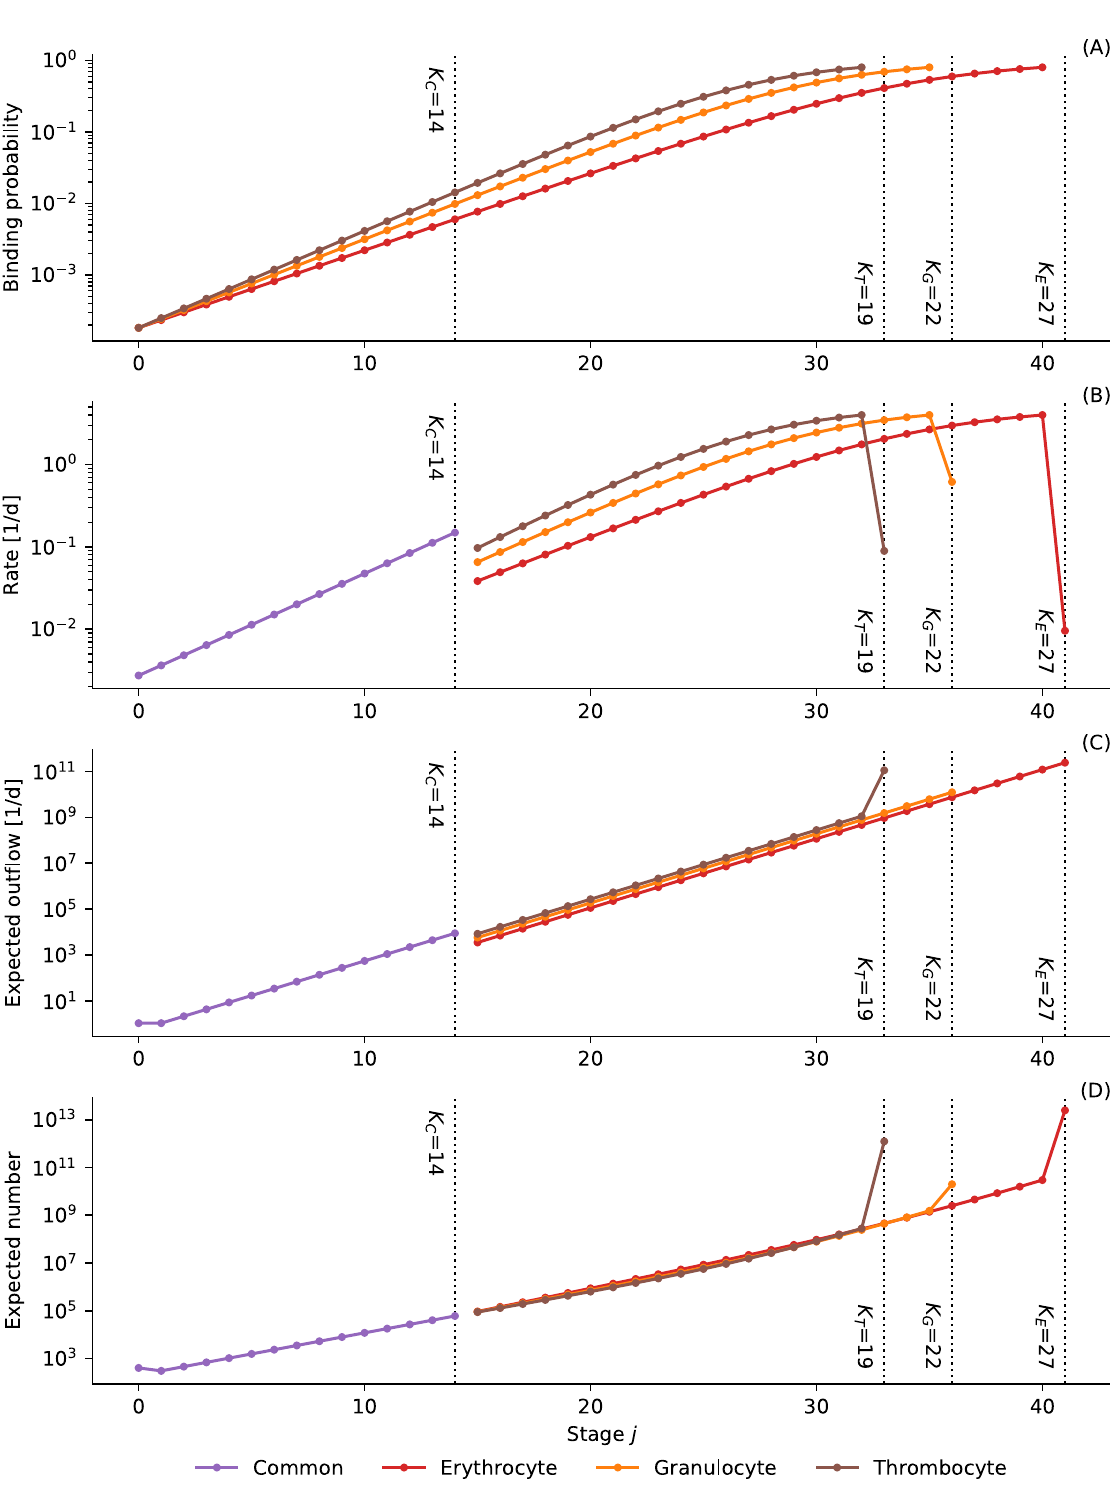
Fig 2. Model stages. Panel (A) shows binding probabilities for the erythrocyte, granulocyte, and thrombocyte growth factors as a function of the differentiation stage. Panel (B) shows the corresponding proliferation rates, except for the last stages of each lineage that model the blood stream. For those the rates correspond to the death rates of erythrocytes, granulocytes, and thrombocytes. Panels (C) and (D) depict the expected outflow and number of cells at each stage. All curves are for the growth factor concentrations at their target values (all c x = 0) and with all parameters set to realistic